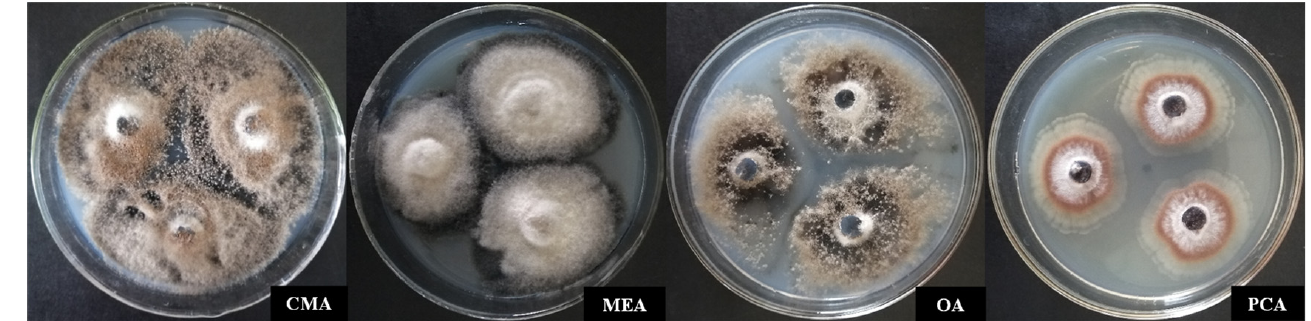
Figure 2. Characteristics of the colonies on media and the morphology of MR ‐ 57 isolate. The front of the colony was cultured on CMA, MEA, OA, and PCA at 25 °C in the dark for 10 days.